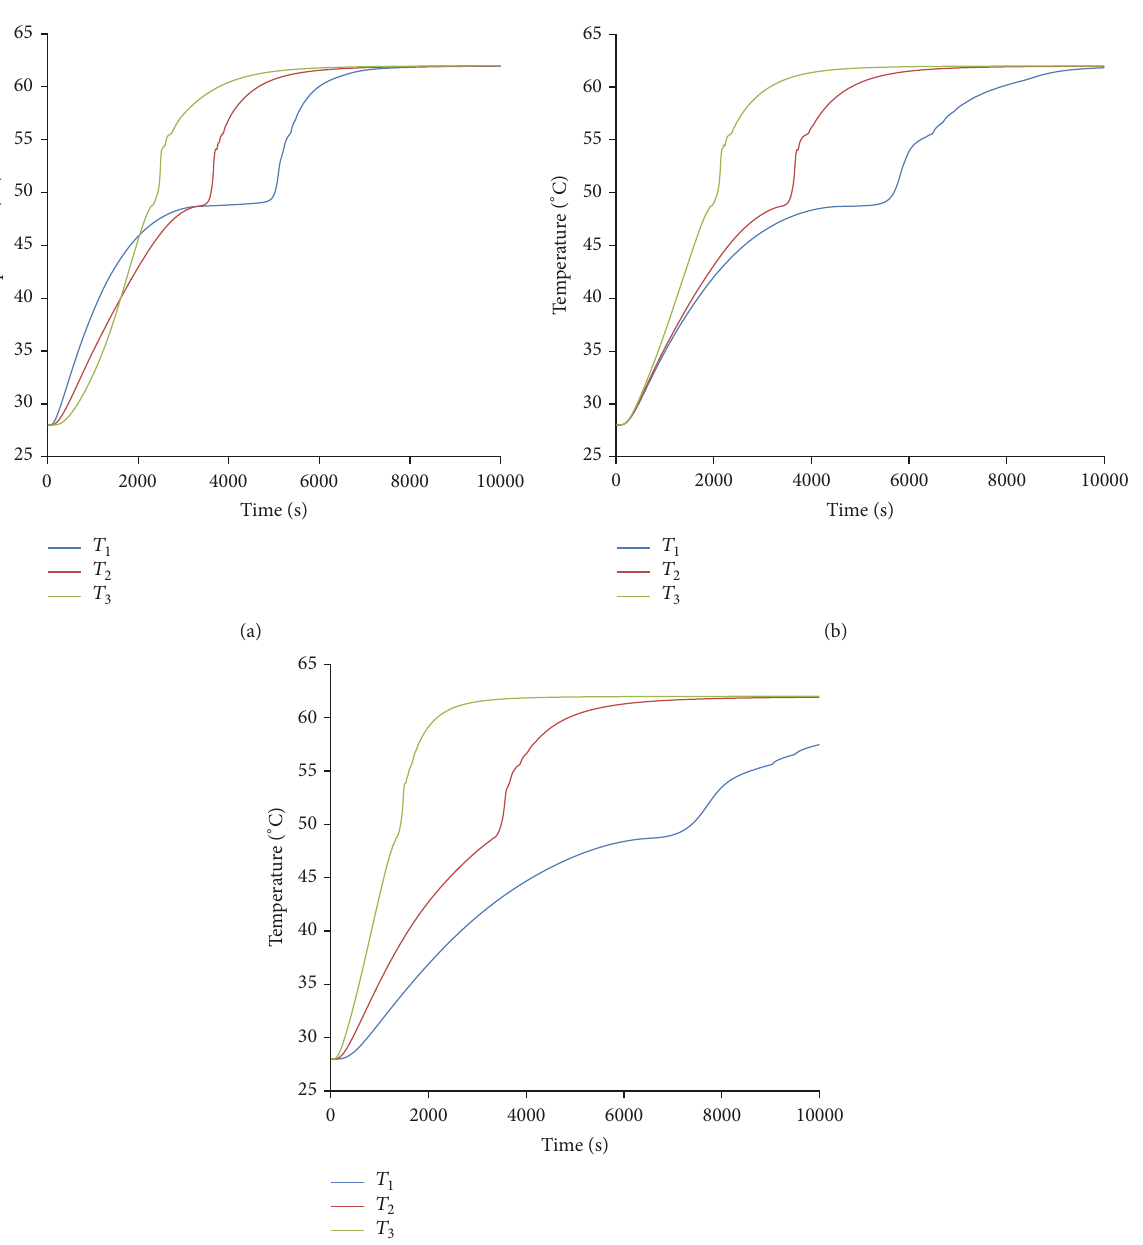
tended to be constant over time and the heat was stored in the form of latent heat. After that, there was a change of paraffin temperature in which the heat absorbed was used to increase the temperature of paraffin until the temperature was the same with the temperature of the hot